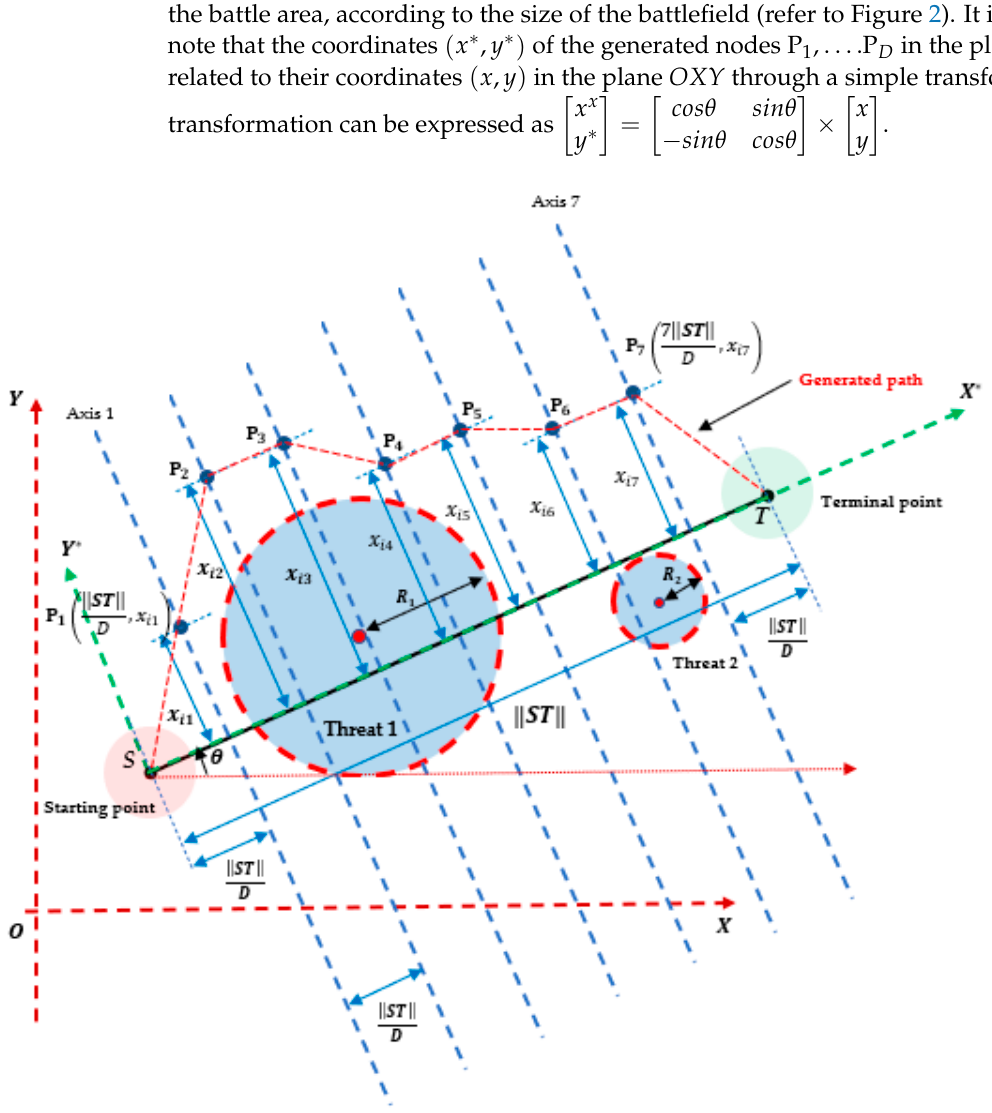
Figure 2. Thorough graphical depiction of the path planning modeling procedure (e.g., here D = 7 and n thr = 2 ).